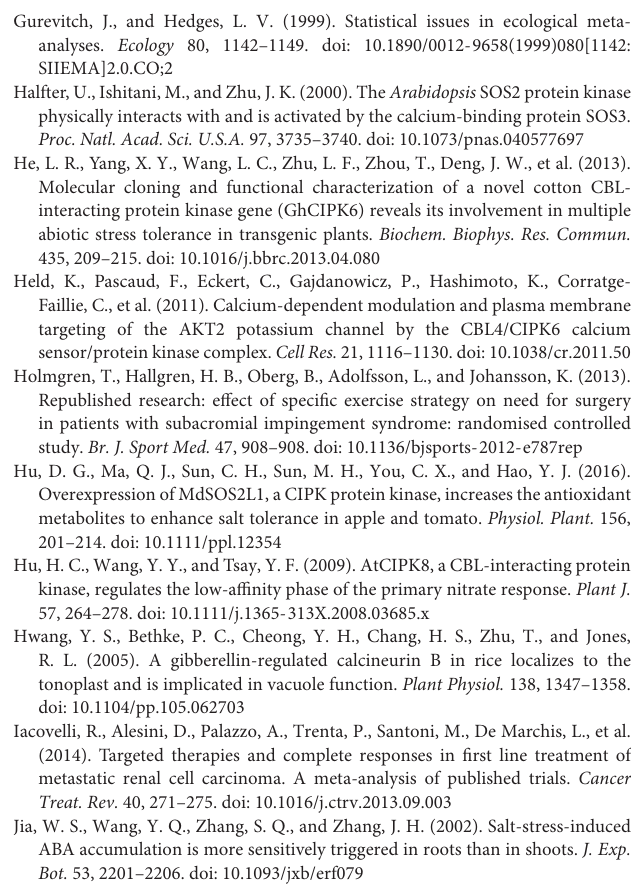
TABLE S1 | Measures used in characterizing publication bias for each effect size of CIPK transformation. TABLE S2 | Measures used in characterizing publication bias for each effect size of CBL transformation. FIGURE S1 | Weighted summary effect sizes (ln R ) and 95% confidence intervals (CIs) showing how moderator variables affect the extent to which CIPK transformation modifies shoot fresh weight. A p ≤ 0.05 indicates that the moderator level was significantly different than zero; n stands for the number of studies. FIGURE S2 | Weighted summary effect sizes (ln R ) and 95% CIs showing how moderator variables affect the extent to which CIPK transformation modifies MDA levels. A p ≤ 0.05 indicates that the moderator level was significantly different than zero; n stands for the number of studies. FIGURE S3 | Weighted summary effect sizes (ln R ) and 95% CIs showing how moderator variables affect the extent to which CIPK transformation modifies proline levels. A p ≤ 0.05 indicates that the moderator level was significantly different than zero; n stands for the number of